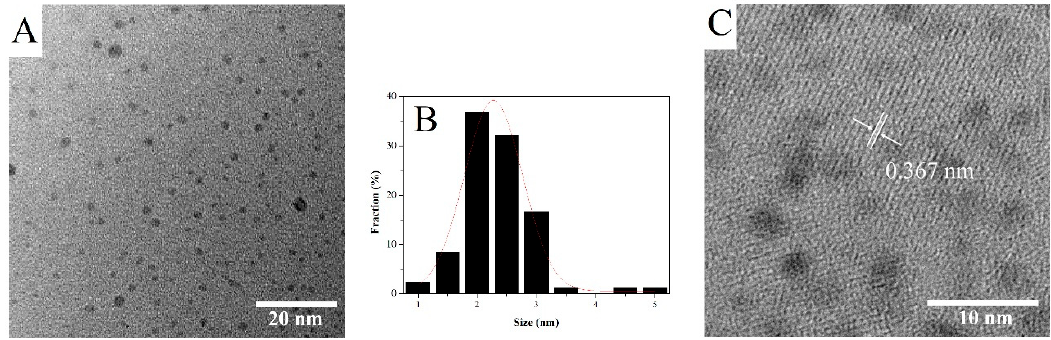
Figure 1. Transmission electron microscopy image ( A ), size distribution histogram ( B ) and high-resolution transmission electron microscopy image ( C ) of the as-synthesized carbon nanodots.